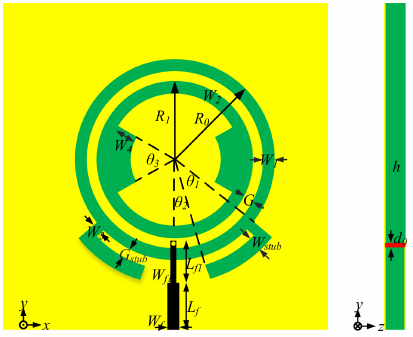
Figure 6. Proposed filtering antenna. R 0 = 21.8 mm, R 1 = 17.5 mm, W 1 = 3 mm, W 2 = 2 mm, W stub = 1.8 mm, W 3 = 6 mm, G stub = 1 mm, G = 1 mm, W 4 = 3 mm, θ 1 = 52 ◦ , θ 2 = 10 ◦ , θ 3 = 60 ◦ , h = 0.5 mm, L f = 24 mm, L f1 = 8.2 mm, W f = 0.92 mm, W f1 = 0.5 mm, h = 0.5 mm.